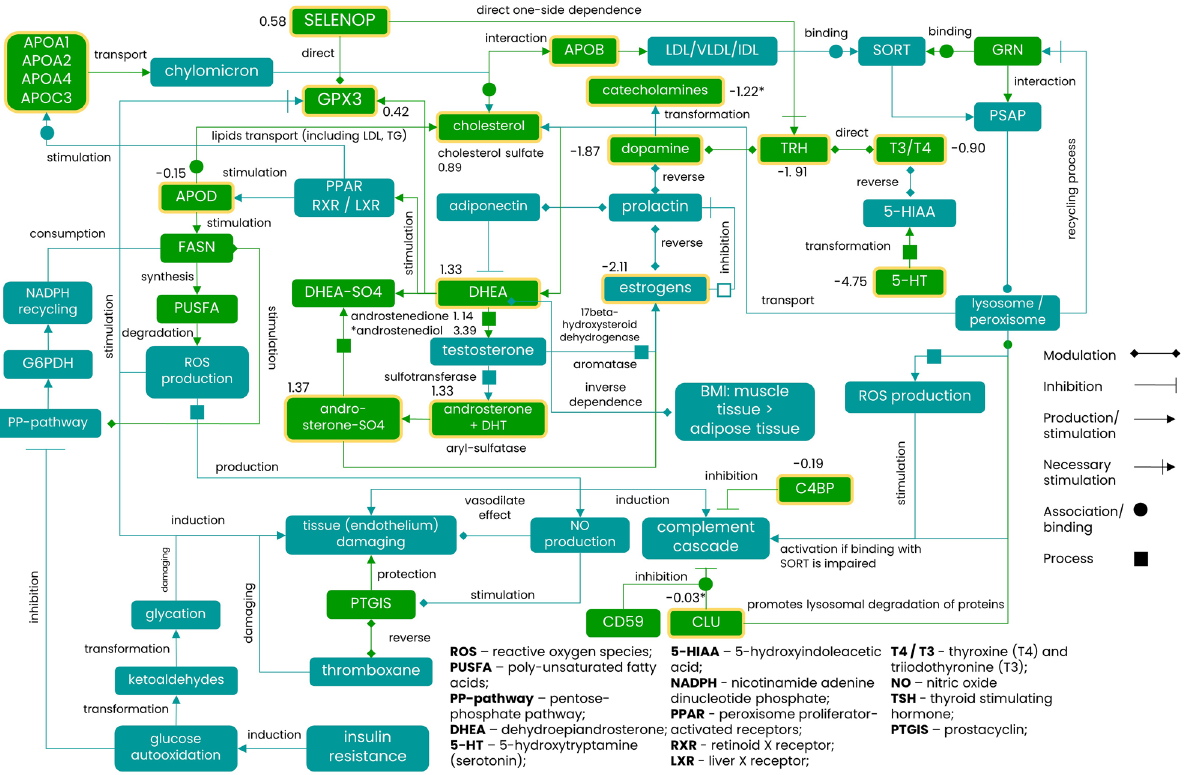
Figure 3. The proposed integrative scheme of interplay between proteome and metabolome layers in patients with schizophrenia. Observed elements (metabolites and proteins) are highlighted by yellow frame and FC (fold-changes) value; the FC observed but insignificant (after running the validation cohort of patients with schizophrenia) are designated by asterisk (*). Although it is almost impossible to figure out the very initial point, still there are several biological processes explicitly outlined on the proposed plane. It seems that the immune response and lipids metabolism might be one of the initial points affected in schizophrenia. The declination of APOA2, APOA4 and APOC1 and lipocalins APOE, APOM, APOH, CLU in combination with the increased oxidative-induced factors (GPX3, APOD, SELENOP) might be a clue. It is worth